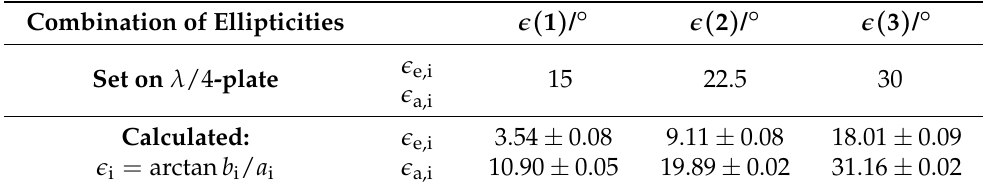
Table 2. Set and calculated ellipticities of incident laser beams for either lasers. Subscripts: e:excitation, a: analysis, i: